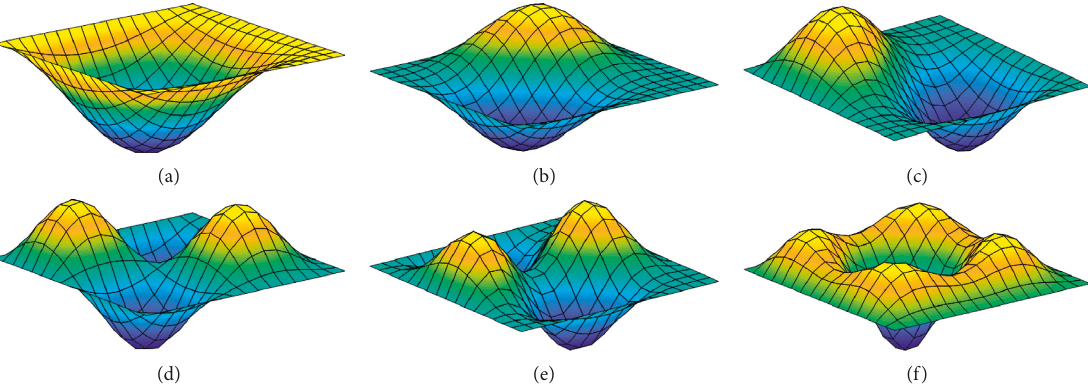
Figure 19: The first six mode shapes of a two-layer square CCSS composite plate. (a) Mode 1. (b) Mode 2. (c) Mode 3. (d) Mode 4. (e) Mode 5. (f) Mode